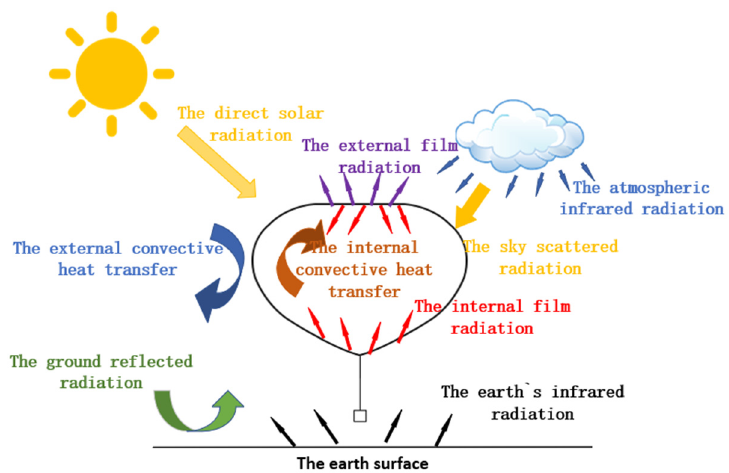
Figure 2. Heat sources for a high-altitude balloon system.